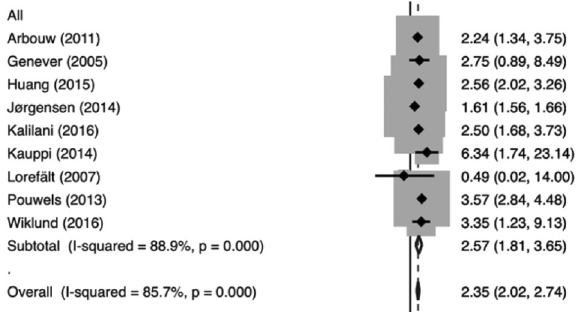
Fig. 1 Meta-analysis of the Association of Hip Fracture in People with Parkinson ’ s Disease. The forest plot shows effect sizes and 95% con fi dence intervals for individual studies, showing an overall estimated increased risk of hip fracture, determined from health records or by self report, in people with Parkinson ’ s disease. Adapted from Schini et al 2020 1 with